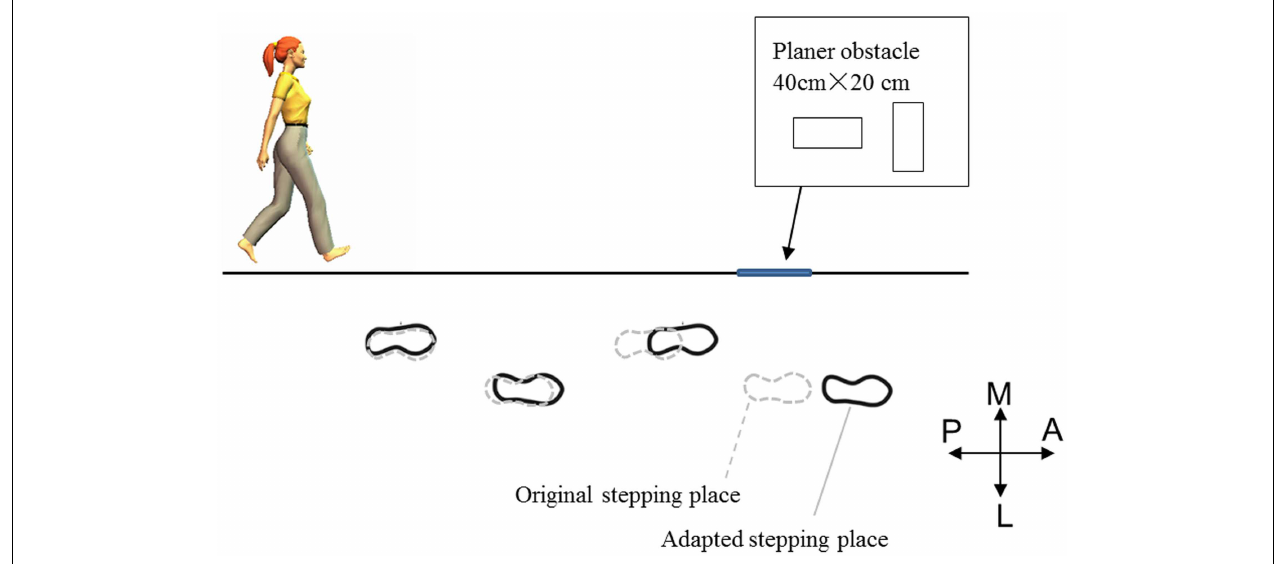
FIGURE 1 |Adapted stride length to avoid an obstacle reported in Moraes et al. (2004) .The participants’ stride was gradually lengthened a few steps prior to reaching the planar